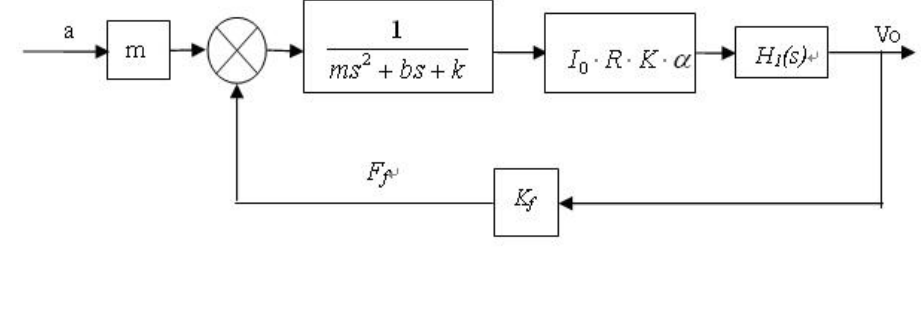
Figure 4. Transfer function diagram of vacuum microelectronic accelerometer